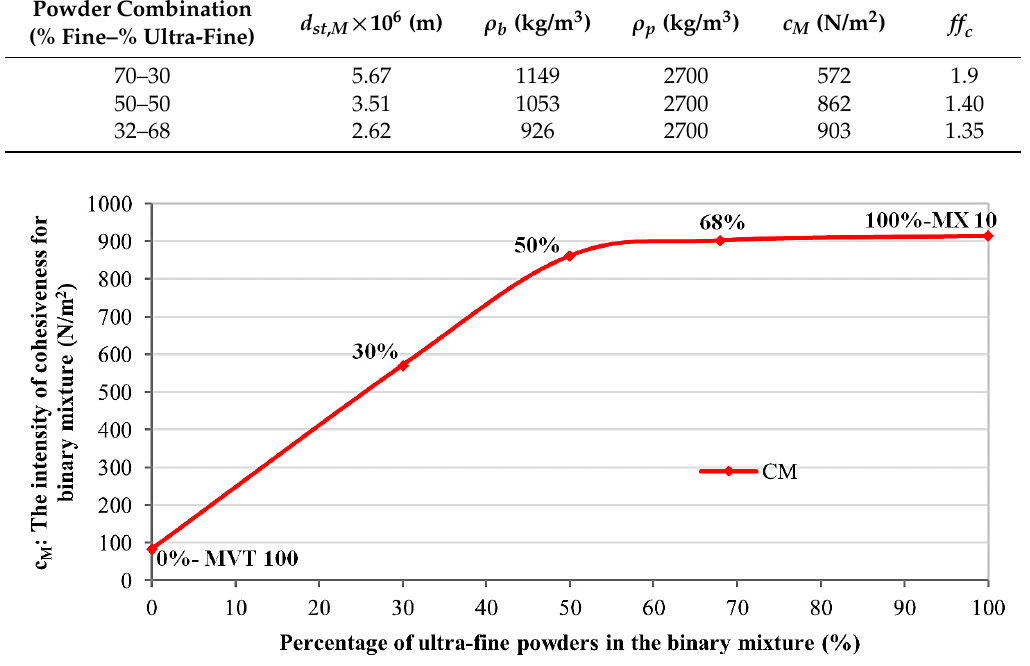
Figure 7. Change in the intensity of cohesiveness for a binary mixture when increasing the percentage of ultra-fine powders.